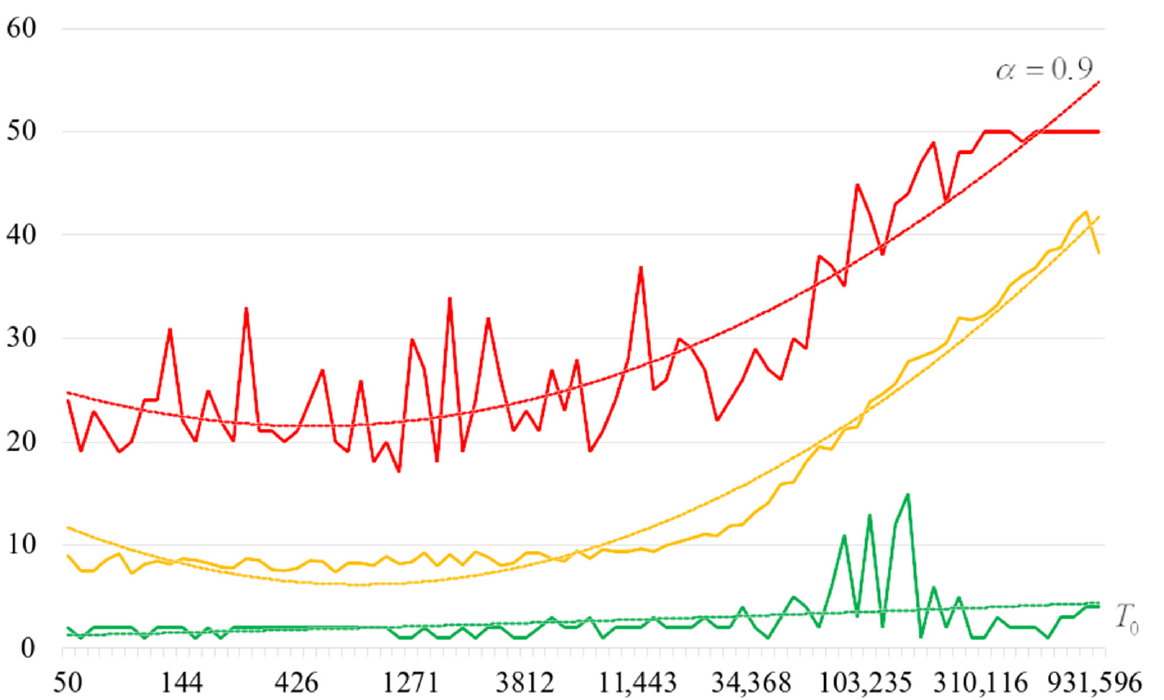
Figure 13. The dependence of the number of iterations of an external loop (until one of the criteria for stopping the algorithm is met), 𝛼 = 0.9 .